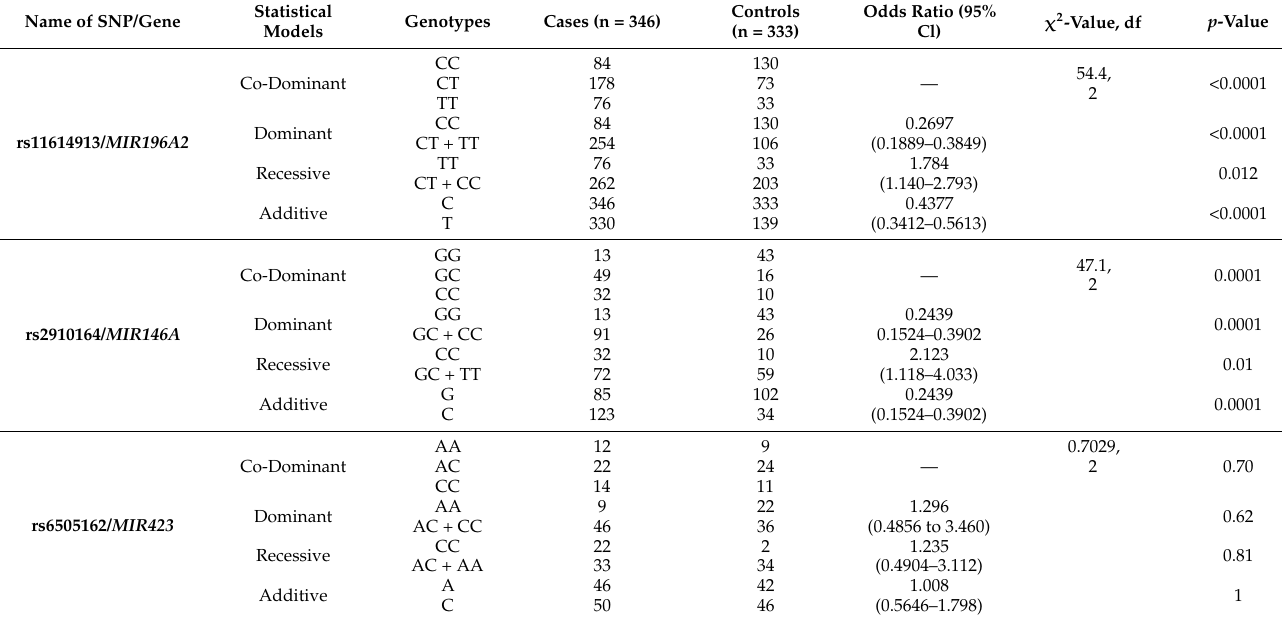
Table 3. Statistical analysis of rs11614913C/T, rs2910164G/C and rs6505162A/C using the co-dominant, dominant, recessive, and additive